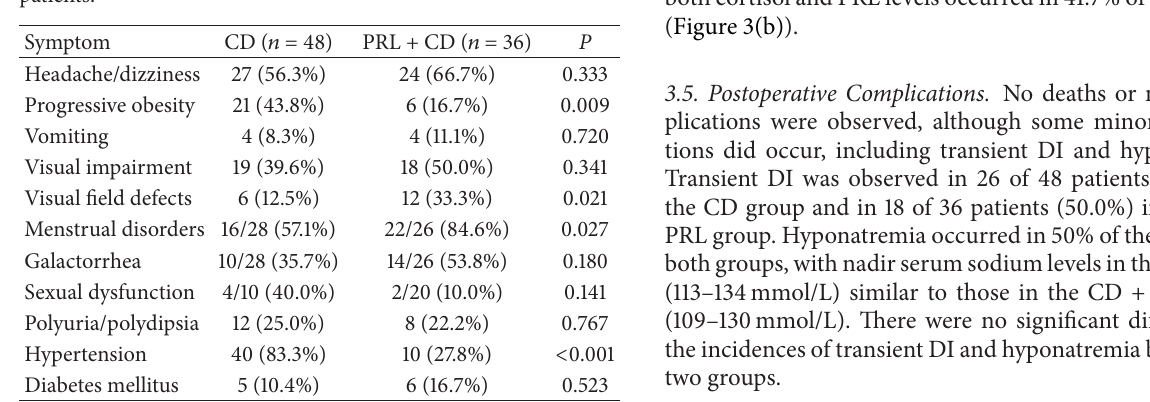
Table 3: Preoperative clinical manifestations in the two groups of